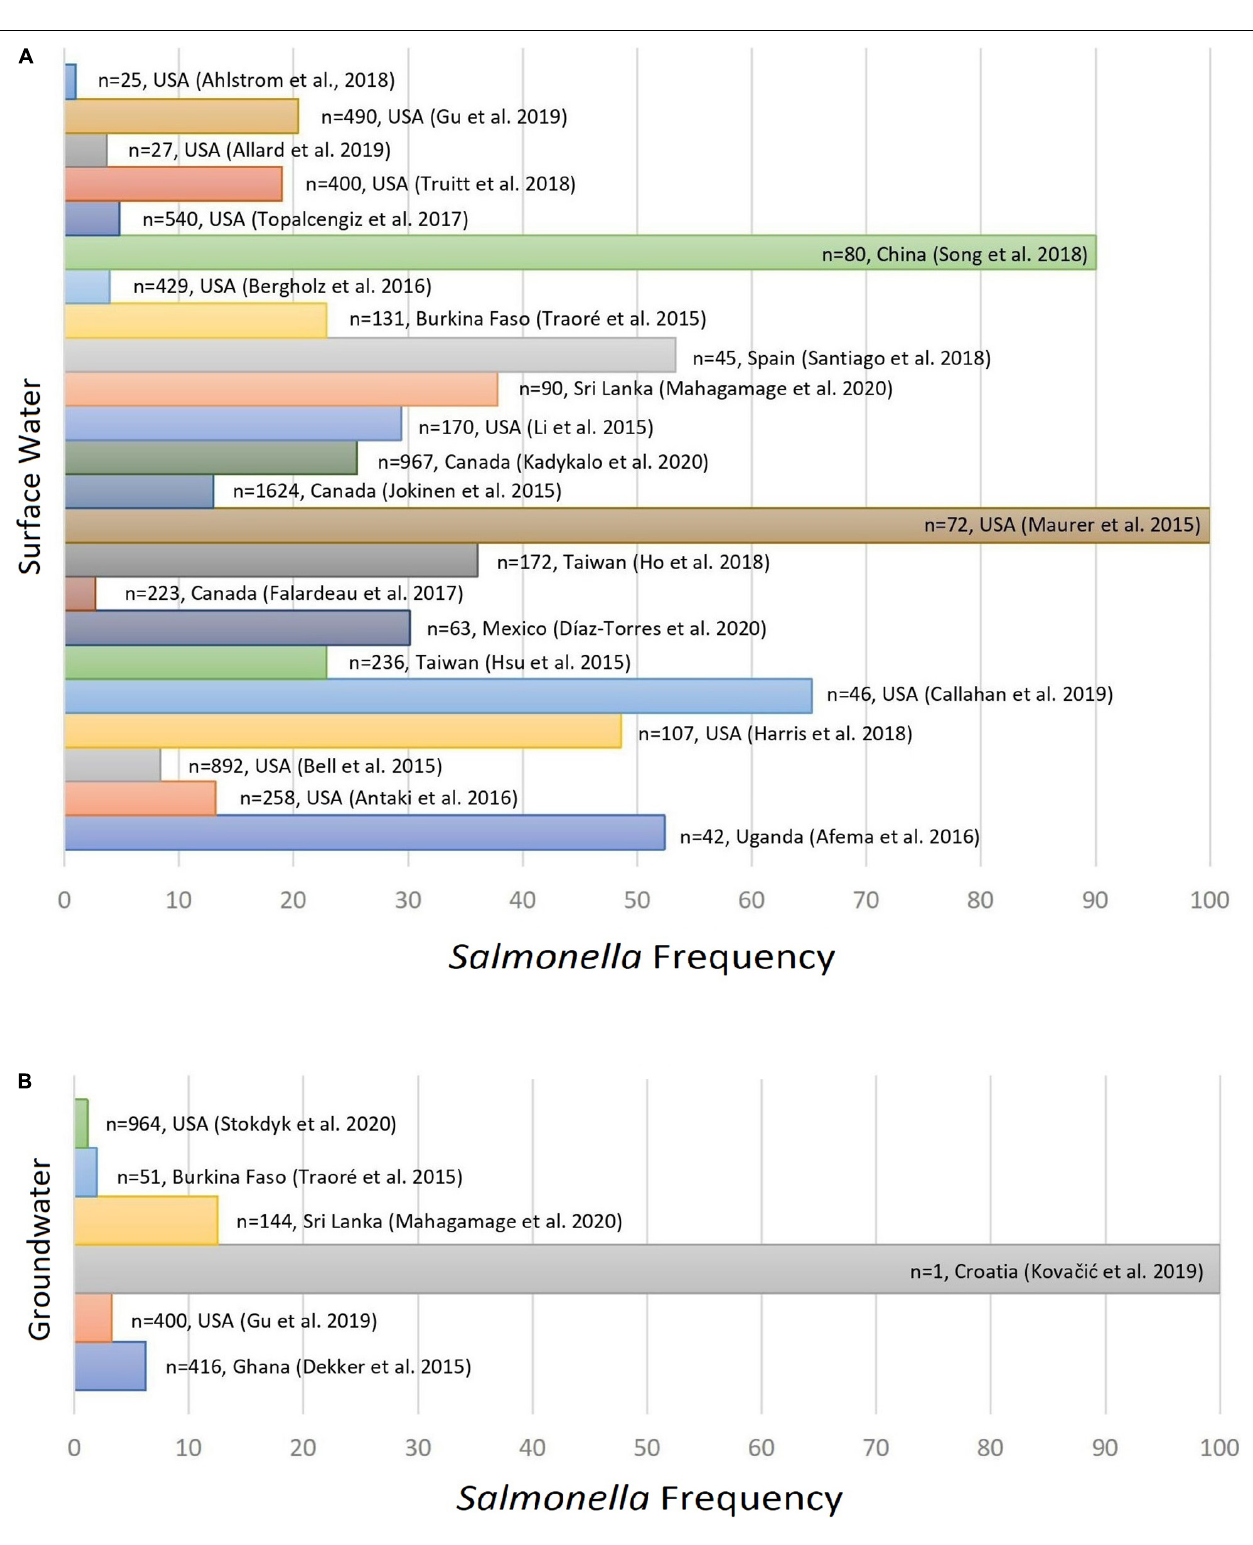
Frontiers in Microbiology |